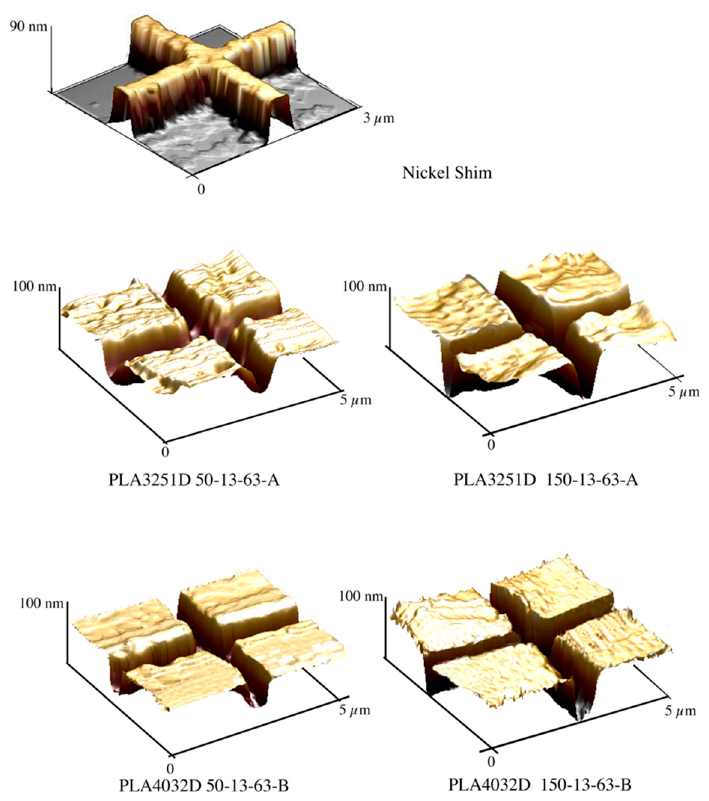
Figure 9. AFM height images of the nanofeatures on the nickel shim, injection-molded samples of PLA3251D and PLA4032D obtained in different conditions of cavity surface temperature.